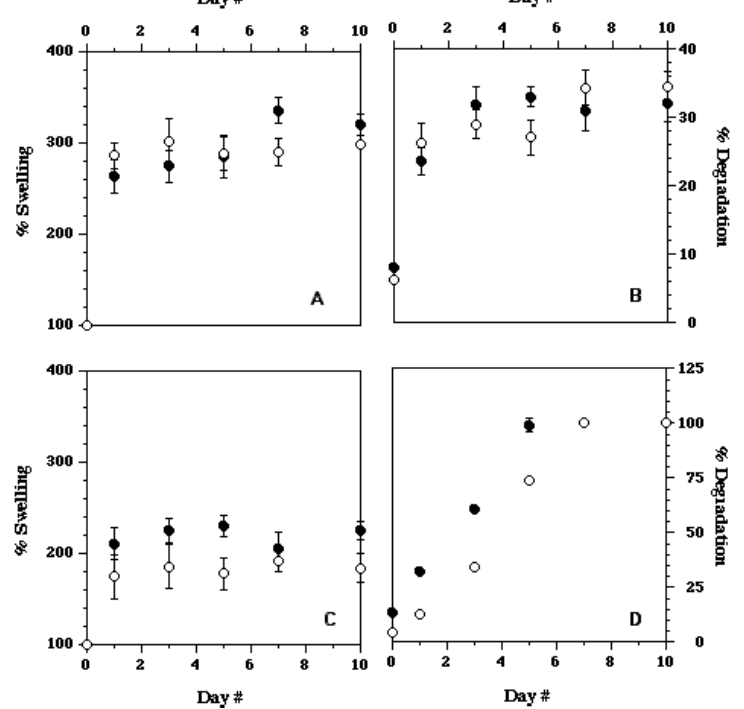
Figure 4. Percent swelling and percent degradation values of MC M7140 (mol. wt = 15,000) system at 14% concentration with 0.5× D-PBS as determined in our laboratory—top two figures. Percent swelling and percent degradation values of hydrogel system developed by Chen et al. [24]—bottom two figures. Note the different values on the y-axis between the top and bottom figures on the right. In each figure the open symbols represent data for 0.5× D-PBS while the filled symbols the corresponding data for 1× D-PBS solutions with MC. The error bars represent the standard deviations in the data (n =